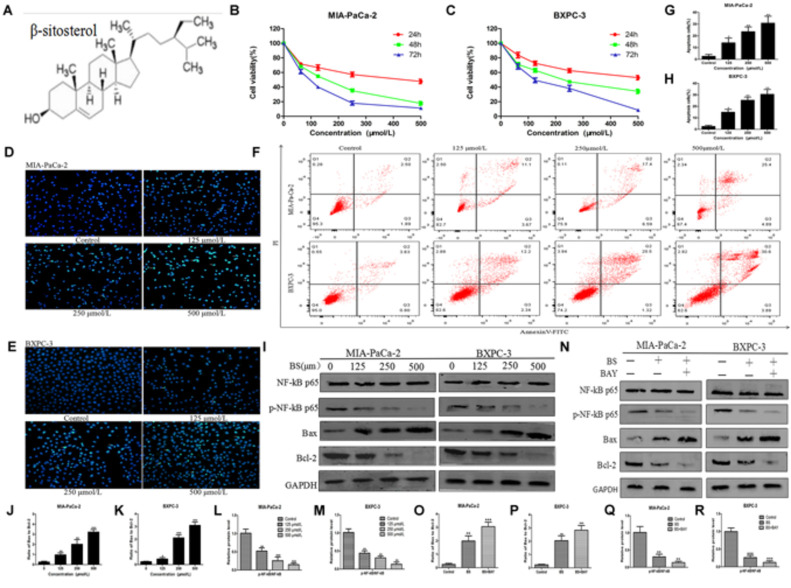
β-sitosterol (BS) effectively inhibits proliferation and induces apoptosis of pancreatic cancer cells. (A) Chemical structure of the indicated drug. (B,C) MIA-PaCa-2 and BXPC-3 cells were treated with various concentration of BS for 24, 48, and 72 h, and the negative control group was treated with an equal volume of medium containing DMSO. Cell viabilities were detected with the MTT assay. All data are depicted as mean ± SD (n = 5). (D,E) MIA-PaCa-2 and BXPC-3 cells were treated with different concentrations of BS for 48 h. Morphological changes in MIA-PaCa-2 and BXPC-3 cells were observed at magnification of 200X. The arrows indicate several apoptotic cells that were shrunken, with fragmented or condensed nucleus and improved brightness. (F–H) MIA-PaCa-2 and BXPC-3 cells were treated with different concentrations of BS for 48 h. Flow cytometry analysis of BS-induced apoptosis of MIA-PaCa-2 and BXPC-3 cells by annexin V–fluorescein isothiocyanate (FITC)/propidium iodide (PI) staining. All data are depicted as mean ± SD (n = 3; ∗P < 0.05; ∗∗P < 0.01). (I–M) MIA-PaCa-2 and BXPC-3 cells were treated with various concentrations of BS for 48 h. The expressions of NF-kB p-65, p-NF-kB p-65, Bax and Bcl-2 in Miapaca-2 and Bxpc-3 cells were analyzed by western blotting, and GAPDH was used as the control. The relative protein levels of the ratio p-NF-kB p-65 to NF-kB p-65, Bax to Bcl-2 were shown in the histograms. All data are depicted as mean ± SD (n = 3; ∗P < 0.05; ∗∗P < 0.01; ∗∗∗P < 0.001). (N–R) MIA-PaCa-2 and BXPC-3 cells were treated with just culture medium, BS (250 μM/L), or both BS (250 μM/L) and BAY (10 μM/L). The expressions of Bax, Bcl-2, NF-kB p-65 and p-NF-kB p-65 in MIA-PaCa-2 and BXPC-3 cells were tested by western blotting, the relative protein levels of the ratio p-NF-kB p-65 to NF-kB p-65, Bax to Bcl-2 were shown in the histograms. All data are depicted as mean ± SD (n = 3; ∗P < 0.05; ∗∗P < 0.01; ∗∗∗P < 0.001).